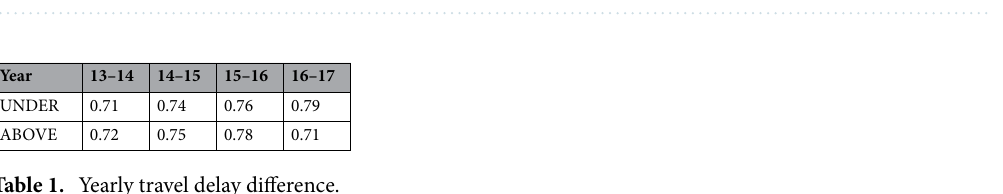
Figure 2. Travel demand and supply evolving.